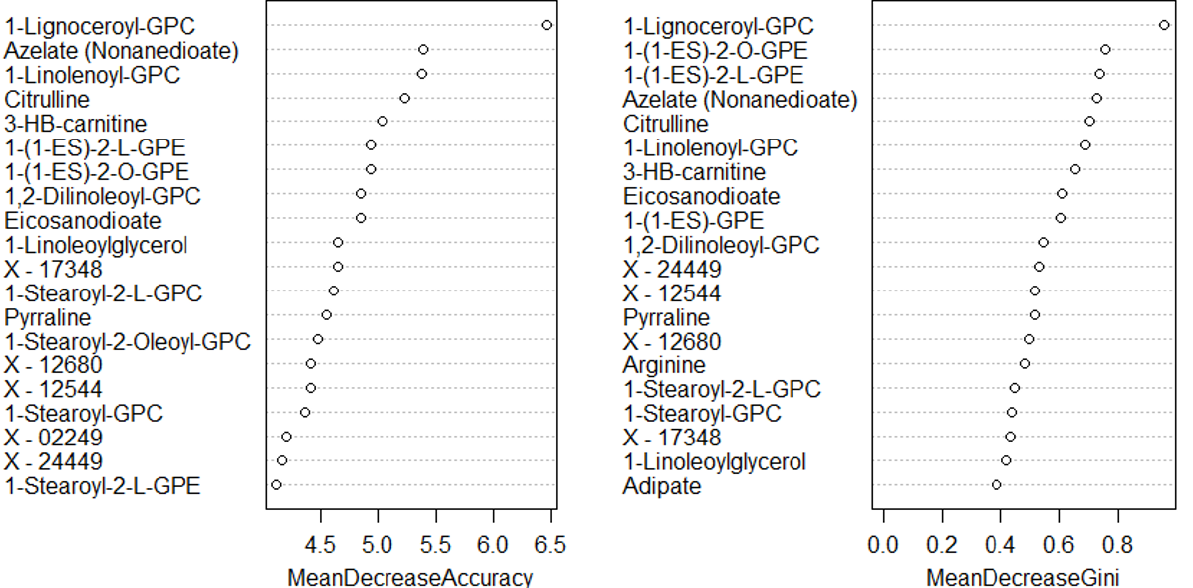
Figure 4. Top 20 discriminatory metabolites identified by random forest machine learning technique and ranked by their contribution to classification accuracy using mean decrease accuracy and mean decrease gini index (node impurity) based on the training set ( n = 109, cancers = 54, controls = 55). Metabolites starting with X are unnamed; the pathways of these are unknown.